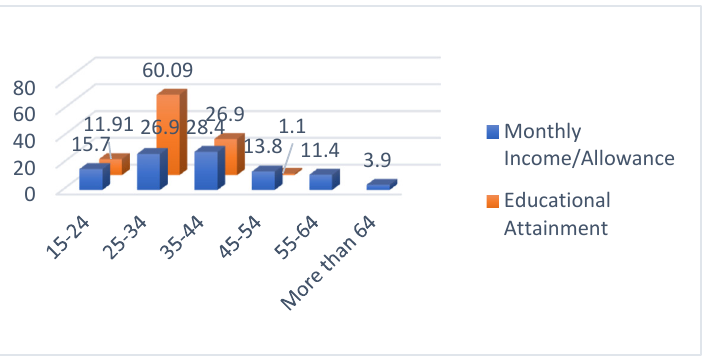
Figure 5. Descriptive Statistics of Income and Education.